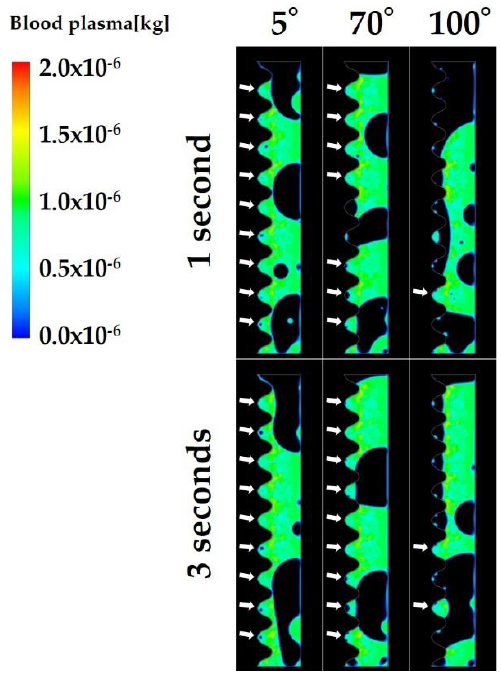
Figure 5. Volume rendering images of the mass of blood plasma. The white arrows show the threads infiltrated with blood plasma.